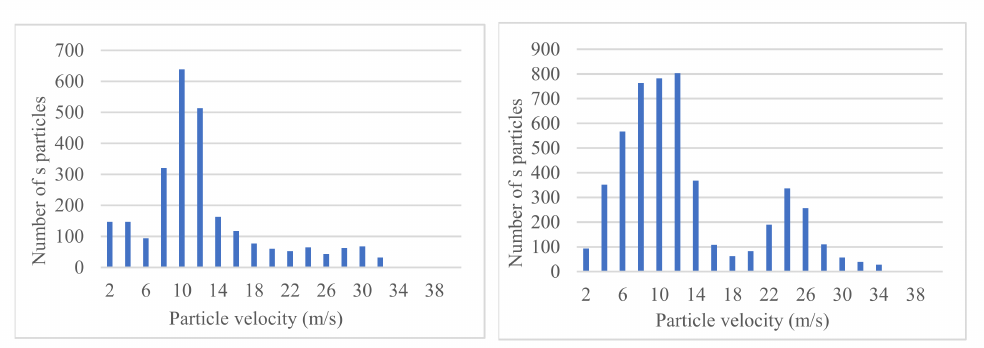
Figure 13. Particle velocity distribution at 1 s and 2 s.